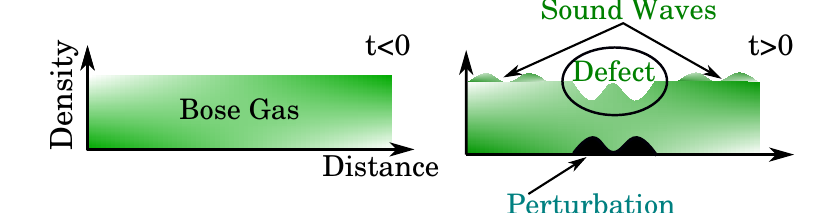
Figure 1: An illustration of the system. A Bose gas which is homogeneous at t < 0 is perturbed at t = 0. At t > 0, the impurity (perturbation) creates a defect in the density of the Bose gas, which resembles the shape of the impurity. Moreover, the impurity generates sound waves, which carry away information about the spatial profile of the